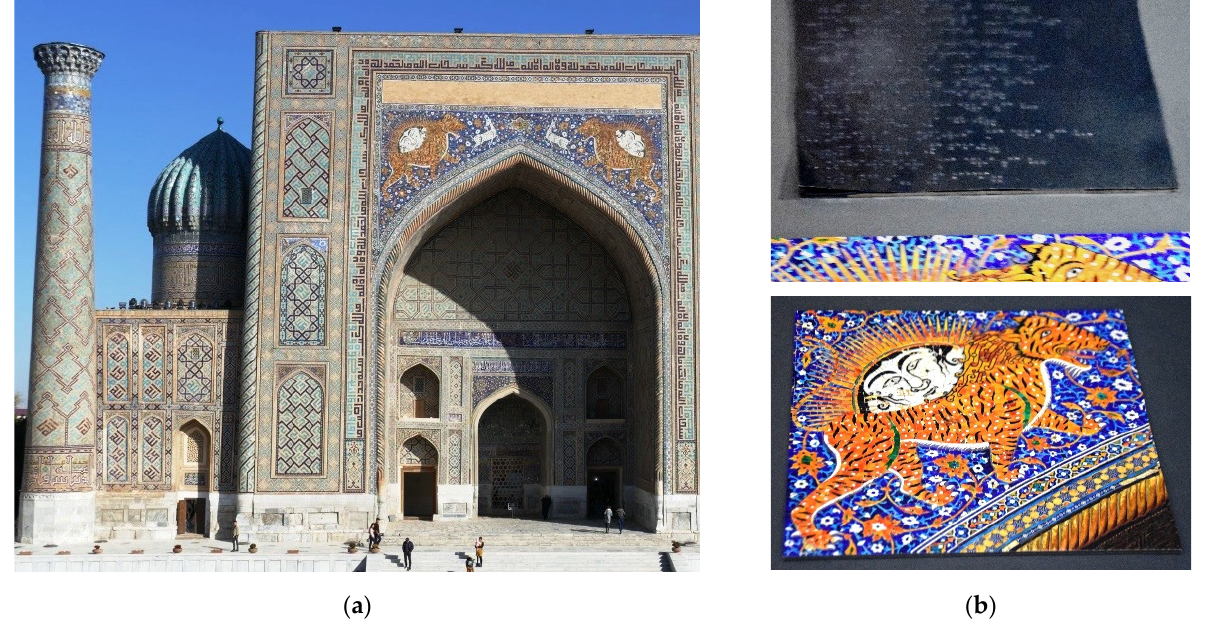
Figure 1. Mosaic from Sher-Dor Madrasah, Registan Ensemble (Samarkand): ( a ) real object; ( b ) miniature for tactile cognition intended for visually impaired people.